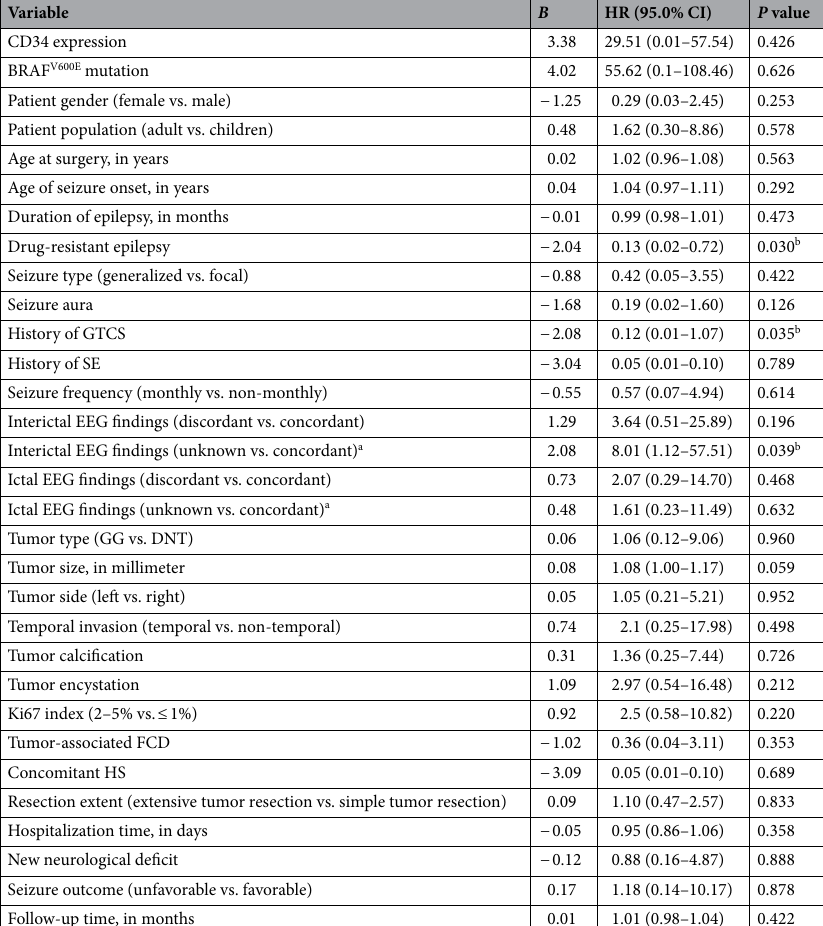
Table 3. Univariate Cox regression analysis of the associations of clinical factors with tumor progression- free survival. GTCS generalized tonic–clonic seizure, SE status epilepticus, EEG electroencephalogram, GG ganglioglioma, DNT dysembryoplastic neuroepithelial tumor, FCD focal cortical dysplasia, HS hippocampus sclerosis, HR hazard ratio, CI confidence interval. a Patients with unknown results in lateral concordant EEG findings of interictal epileptiform discharges and of ictal seizure rhythms were those with no IEDs or normal EEG findings and those with no ictus during video EEG monitoring. b P < 0.05, with